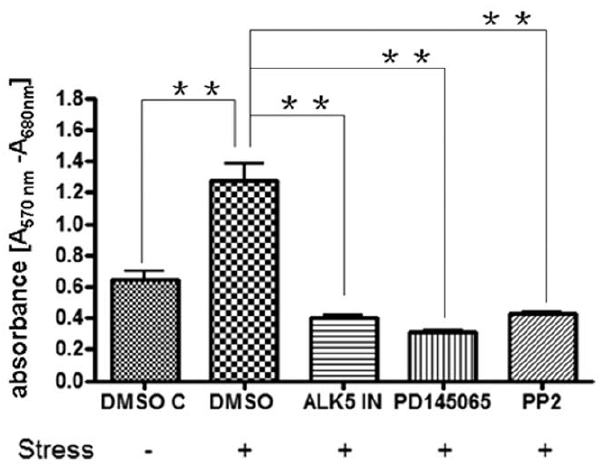
Figure 7. Strain induces proliferation of human gingival fibroblasts. As described in Methods, equal numbers of HGF were seeded into plates containing collagen type I-coated membranes, and were treated with or without mechanical strain for 72 hours. Cells were harvested, and subjected to the MTT assay of cell metabolism, an indirect method of detecting cell proliferation, as described in methods. Cells were treated in the presence or absence of DMSO, the ALK5 inhibitor SB431542, PP2, blebbistatin or the ETA/B receptor antagonist PD145065, as indicated. Data shown are the average value from three independent individuals (6 replicates per experiment ) 6 SE. **=p ,